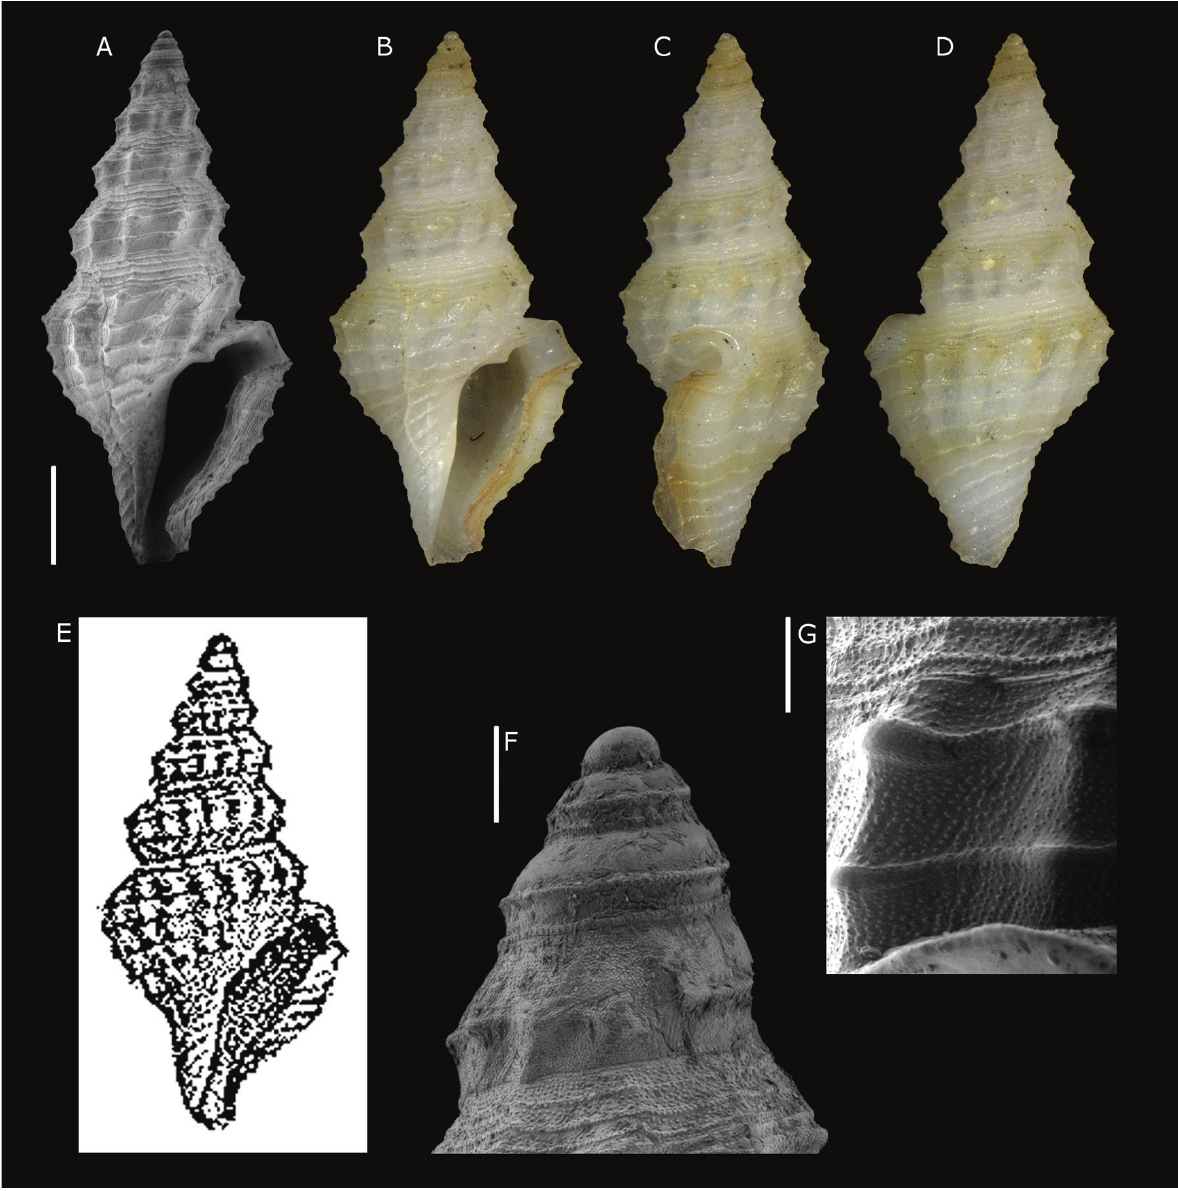
Figure 25 . Mangilia pertabulata Sturany, 1903, Station 145 (Dahlak Archipelago, Eritrea, Red Sea). A–D , F–G . Holotype, NHMW 84255: front ( A–B ), right side ( C ), back ( D ), protoconch ( F ), microsculpture ( G ). E . Original figure by Sturany (1903). Scale bars: A–D : 1 mm, F–G : 0.2 mm.